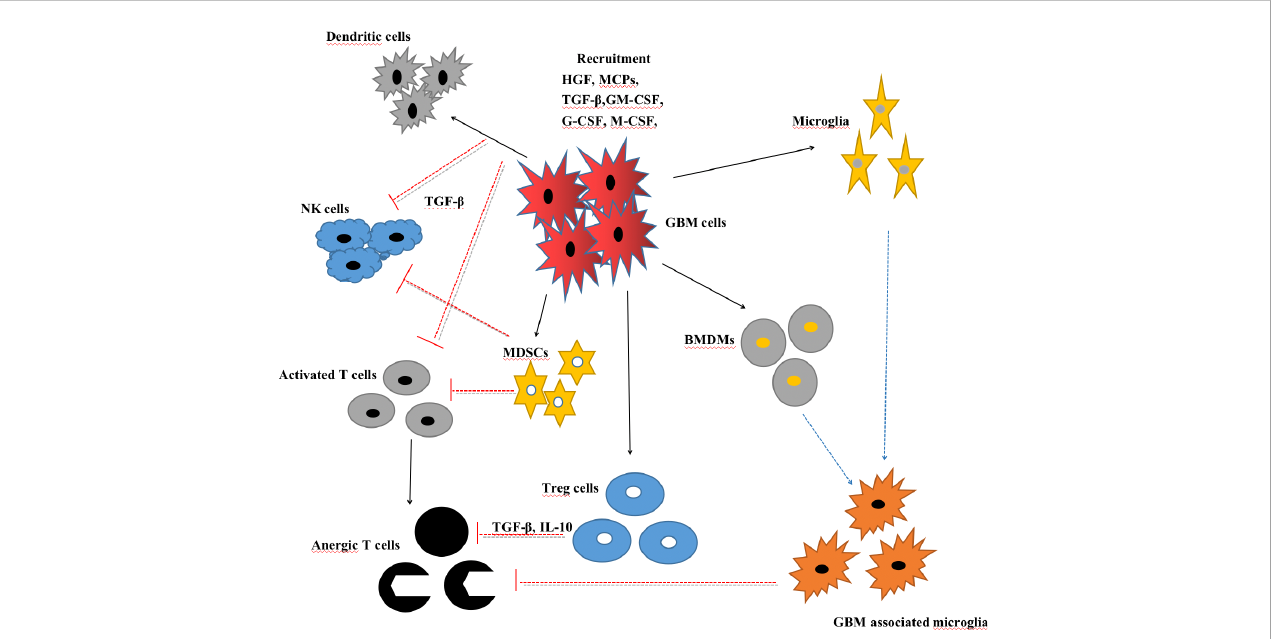
FIGURE 2 Interactions between glioblastoma (GBM) cells and myeloid cells, including microglia, GBM-associated microglia, bone marrow-derived macrophages (BMDMs), myeloid-derived suppressor cells (MDSCs), T cells, natural killer (NK) cells, and regulatory T cells